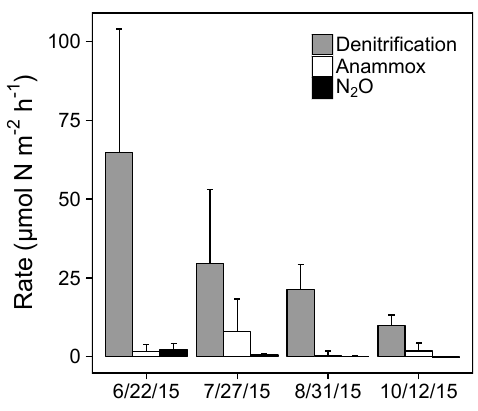
Figure 4. Denitrification, anammox, and N 2 O production rates at station 1163. Error bars represent +